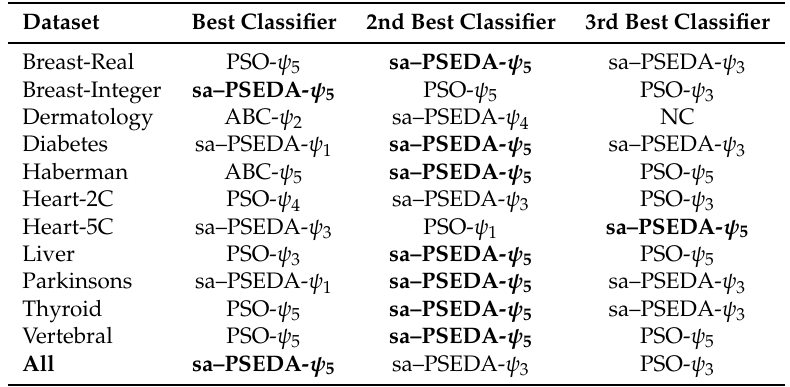
Table 5. Best Swarm Intelligence (SI) classification methods (plus nearest centroid